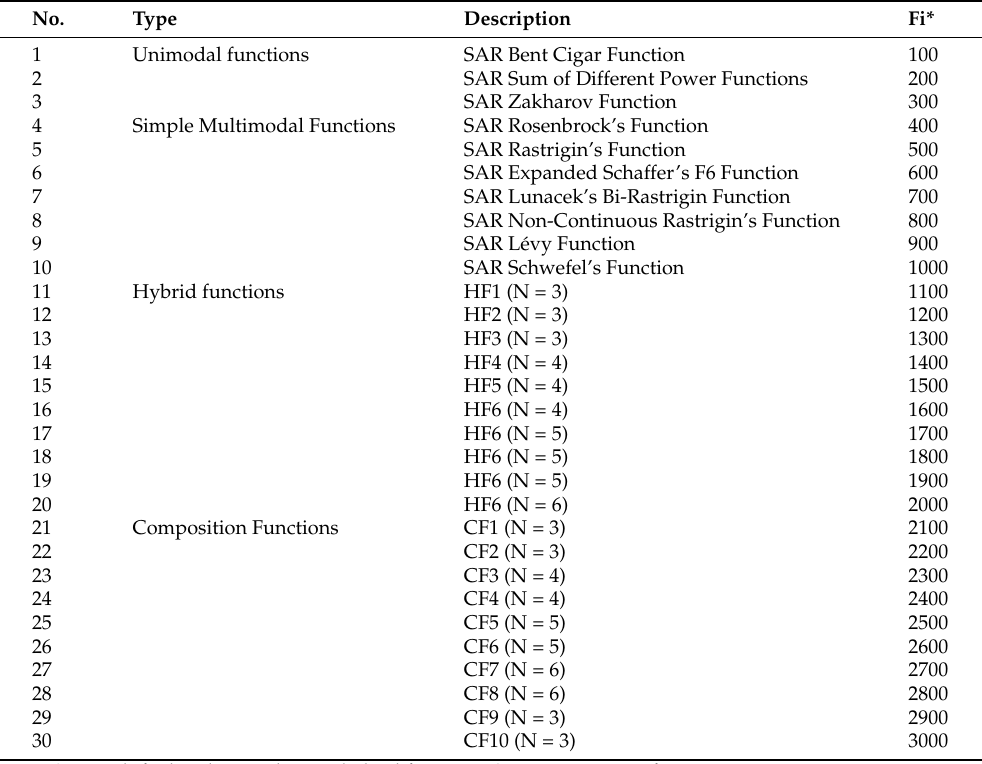
Table 9. Description of CEC2017